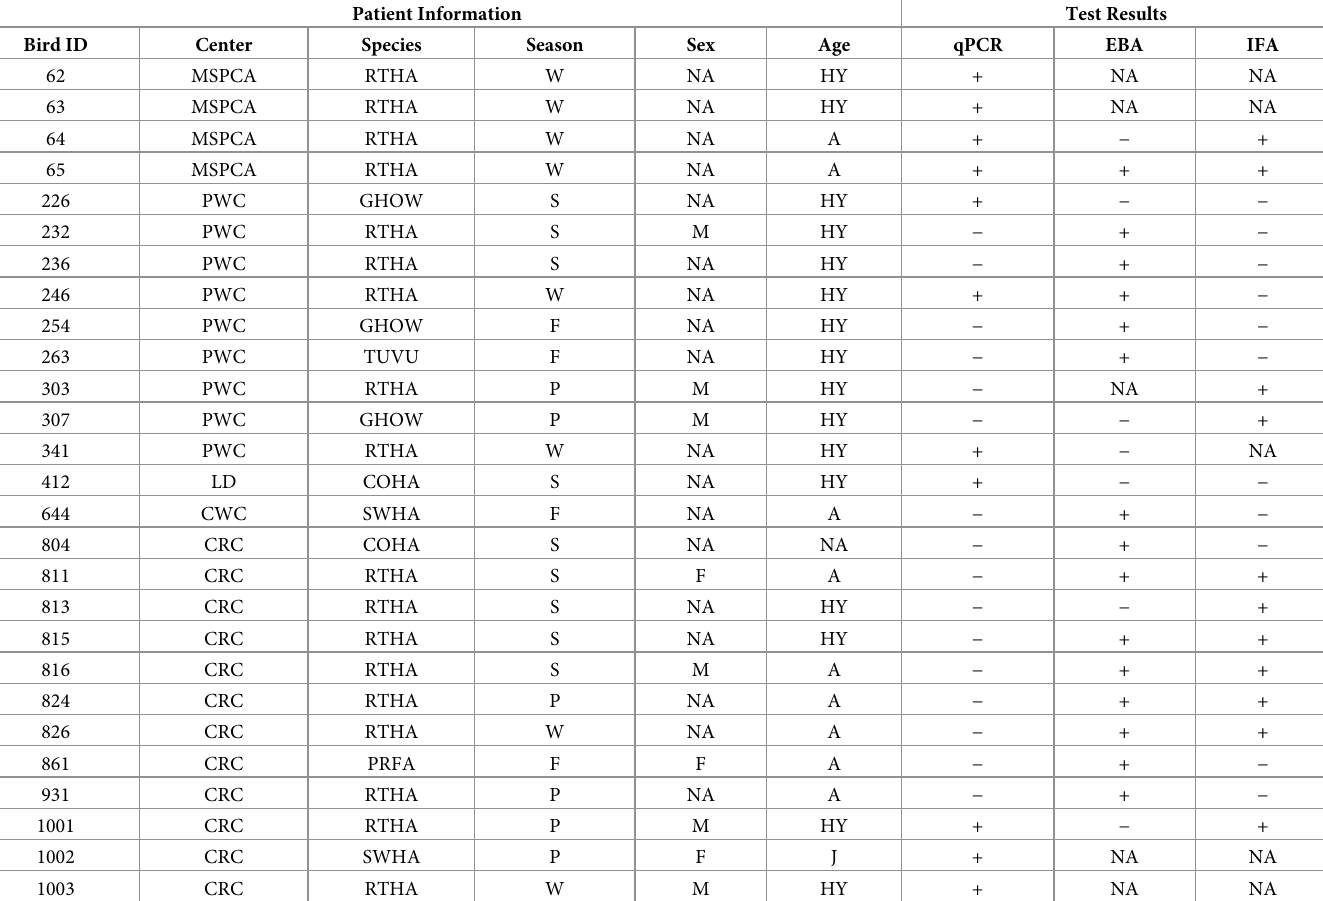
Table 2. Comparative risk factors for raptors for positive qPCR (n = 263), elementary body agglutination antibodies (EBA; n = 190), or immunofluorescent anti- bodies (IFA; n = 186) with species, age class, wildlife rehabilitation center, and season of